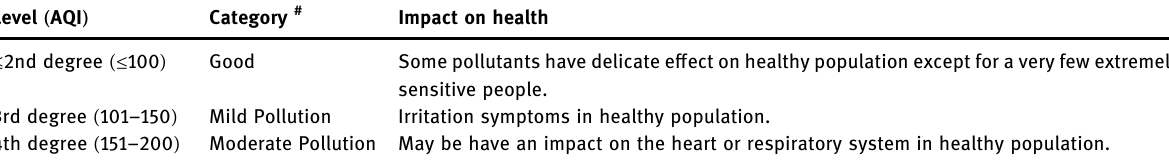
Table A2: Air quality index and impact on